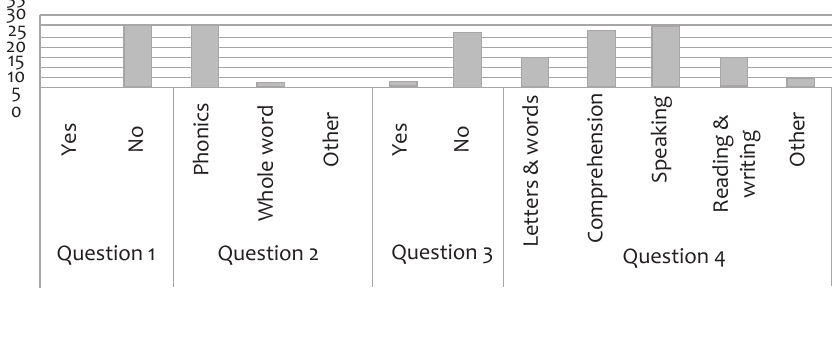
Figure 8: Interview